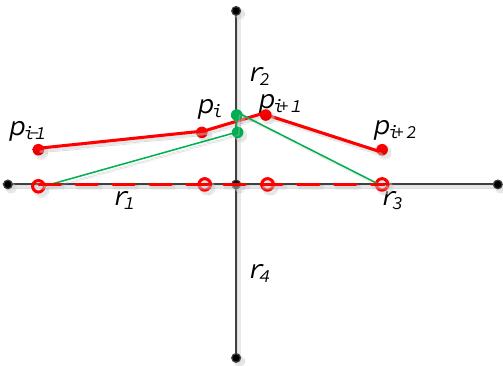
Figure 1. Incorrect matching of intersection trajectory points. Points p i and p i+ 1 are matched to r 2